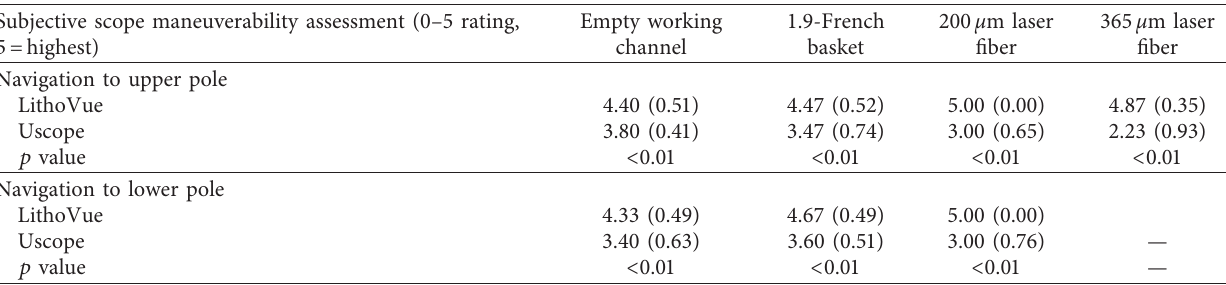
Table 2: Subjective surgeon assessment of maneuverability between LithoVue and Uscope for navigation to upper and lower poles when the working channel is empty, with a 1.9-French basket, a 200 μ m laser fiber, and a 365 μ m laser fiber (upper only).